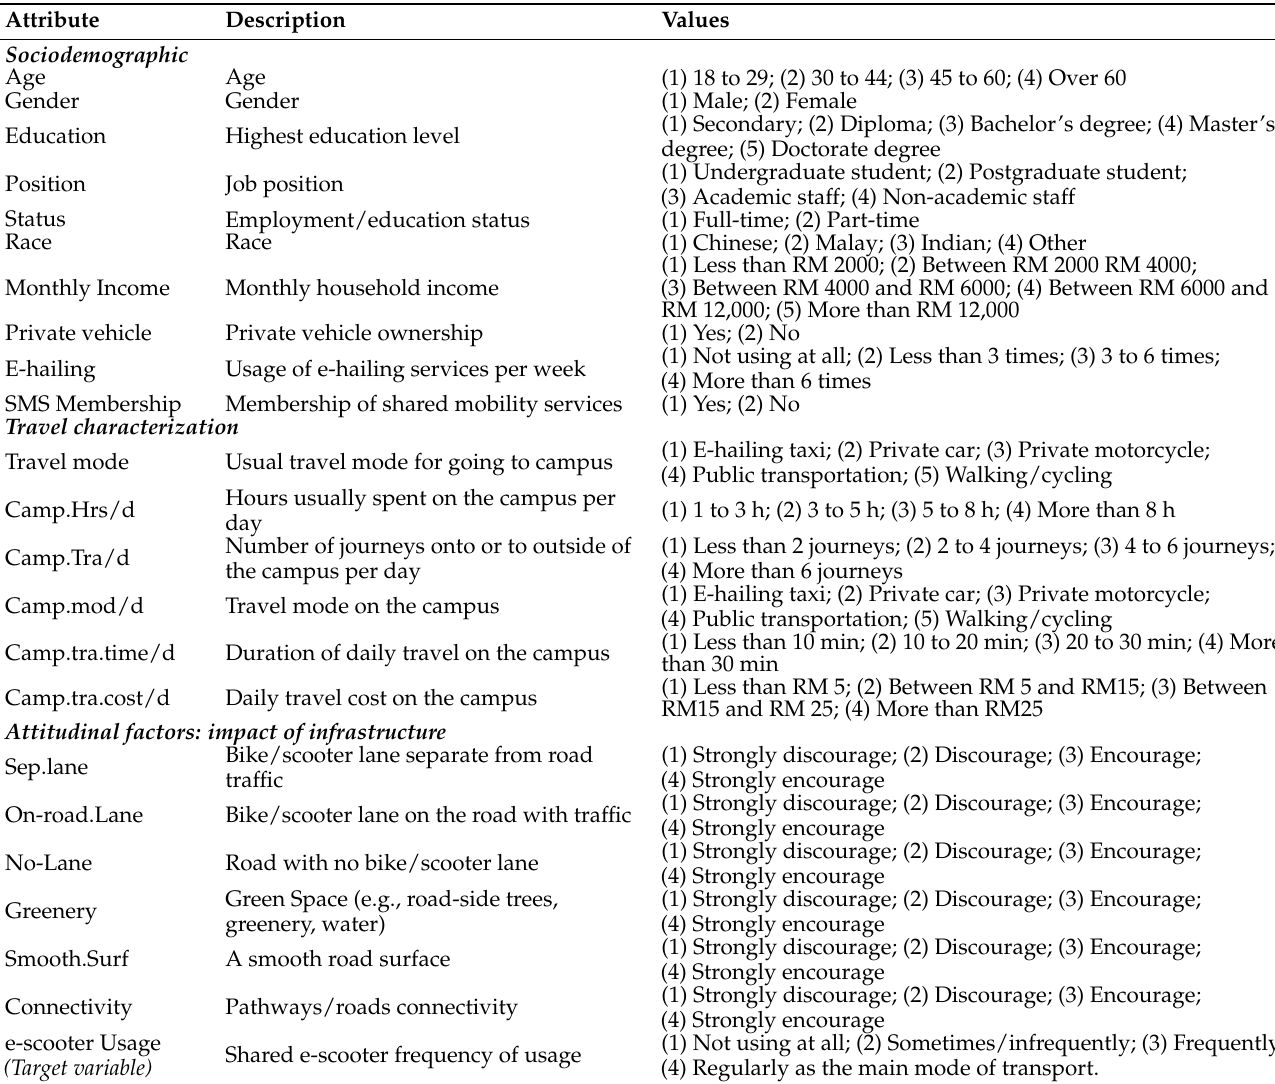
Table 1. Variables used in this study for